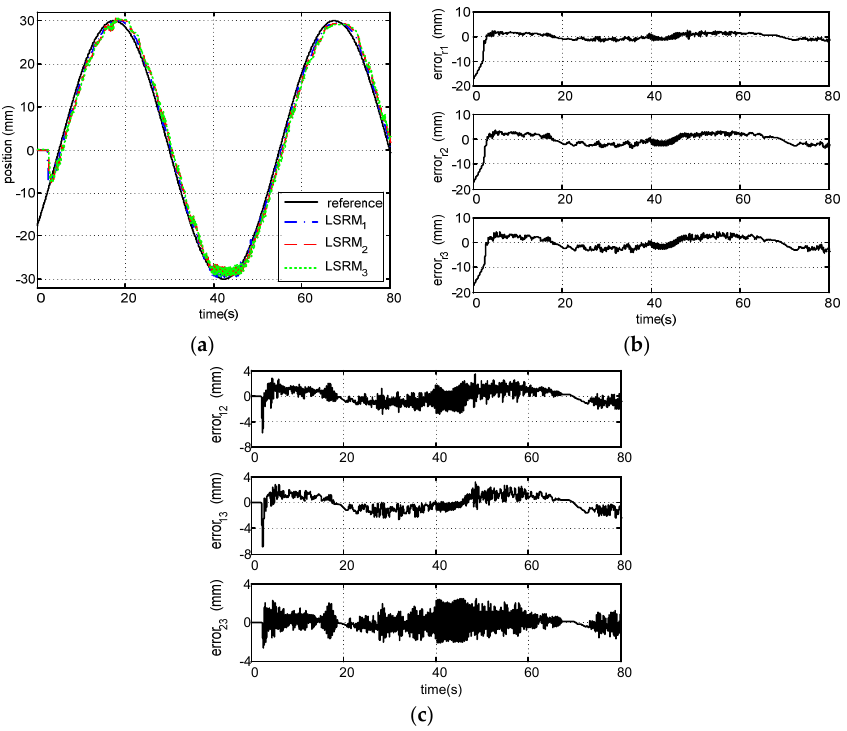
Figure 5. Tracking profiles ( a ) LSRMs; ( b ) error response to reference; and ( c ) relative error response between LSRMs without leader ‐ based feedback.